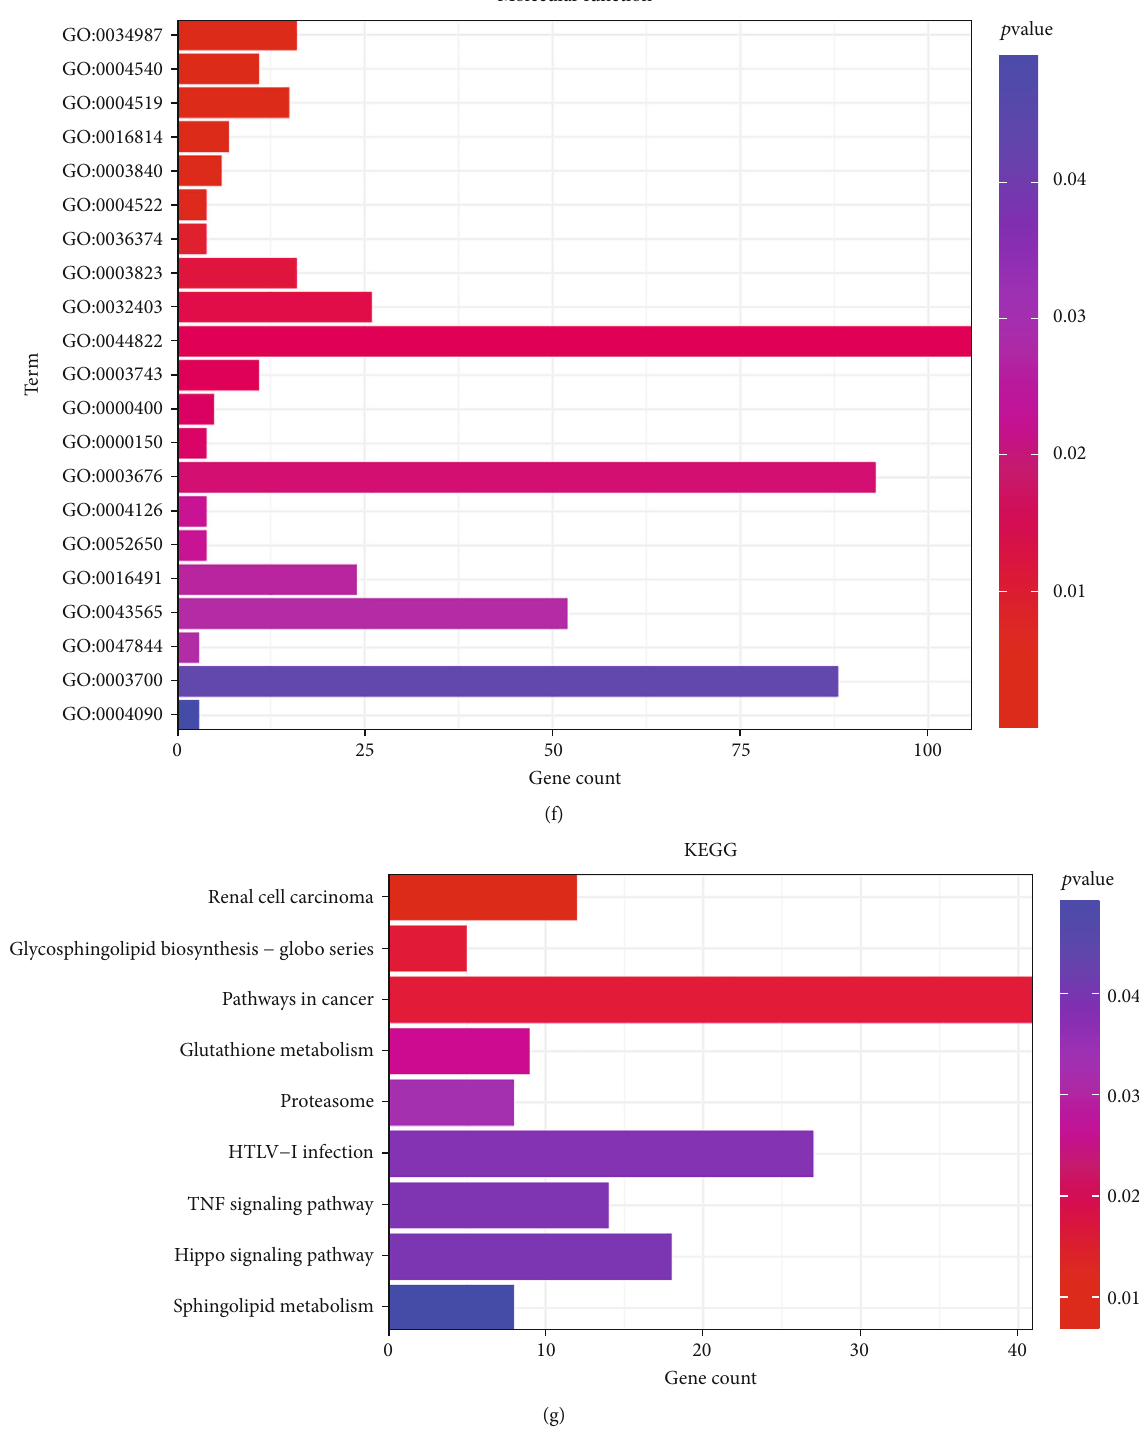
Figure 5: YY1 co-expression genes in ESCA (LinkedOmics). (a) The global YY1 highly correlated genes identi fi ed by spearman test in TCGA-ESCA cohort. Red indicates positively correlated genes and green indicates negatively correlated genes. (b, c): Heat maps showing top 50 genes positively and negatively correlated with YY1 in ESCA. (d) Top 22 GO terms according to biological processes. (e) The GO terms according to cellular components according to P value. (f) The GO terms according to molecular functions. (g) The KEGG pathway terms according to P value. The size of each node indicates the gene number in the corresponding pathway, whereas the P value is shown by the color. The redder the color, that is the more signi fi cant. GO: Gene Ontology; KEGG: Kyoto Encyclopedia of Genes and